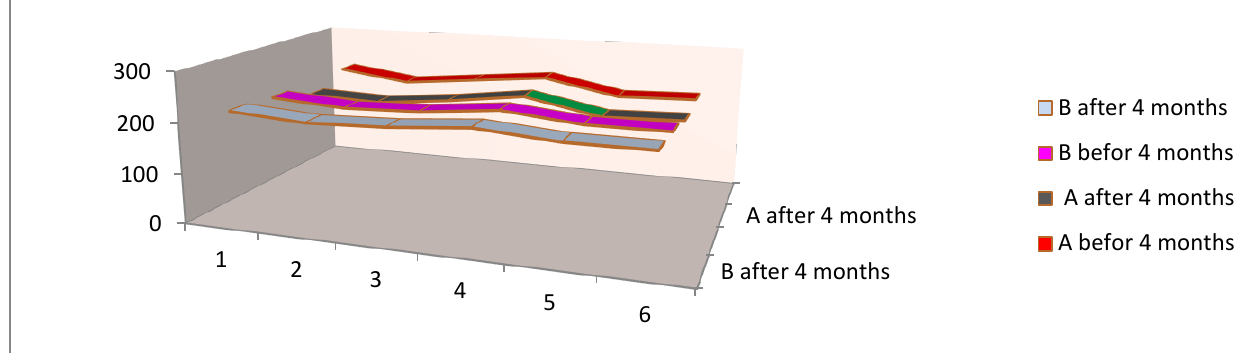
Fig. 4. Comparison of the two groups' mean total Cho. (mg/dl) with time (baseline and after four months)